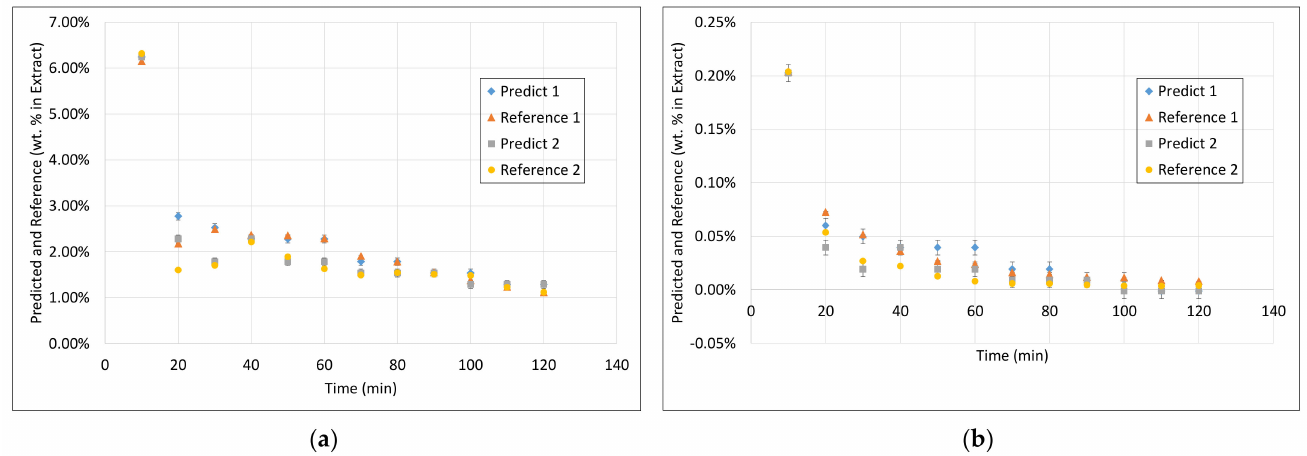
Figure 11. Extraction profiles with reference offline analytics and predicted with correlation of conductivity measurement for ( a ) dry residue and ( b )